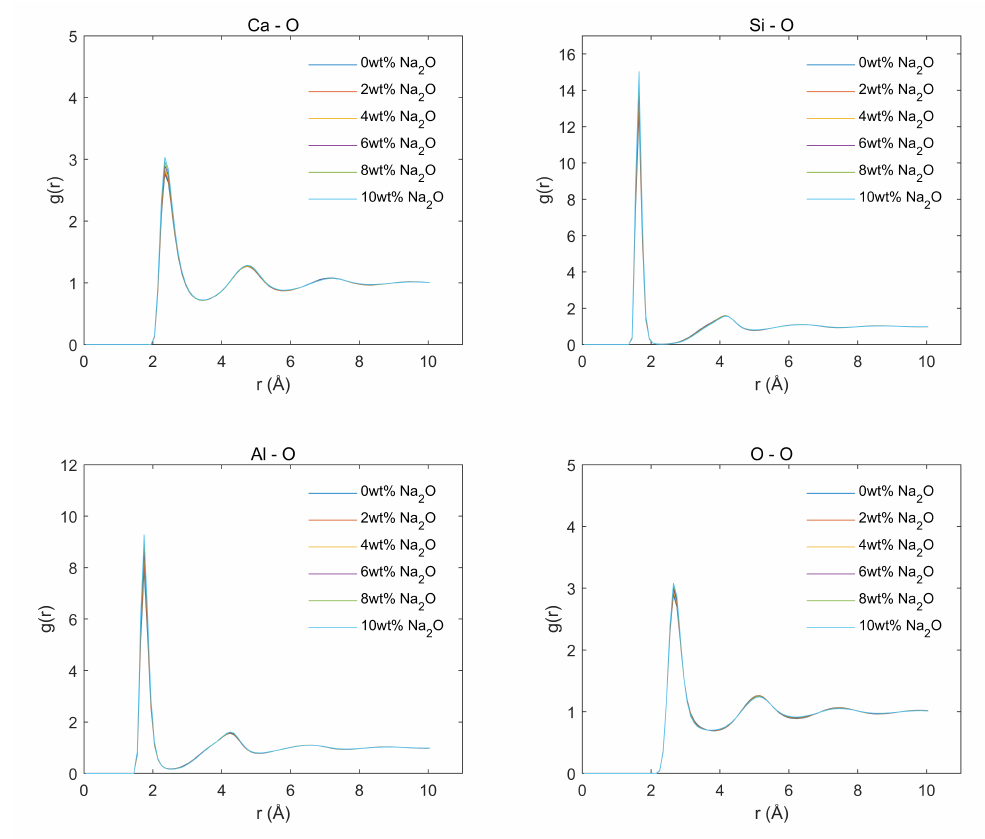
Figure 9. Radial pair distribution functions g ( r ) of various pairs of atoms for Na 2 O–CaO–Al 2 O 3 –SiO 2 systems with different Na 2 O contents at 2000 K.